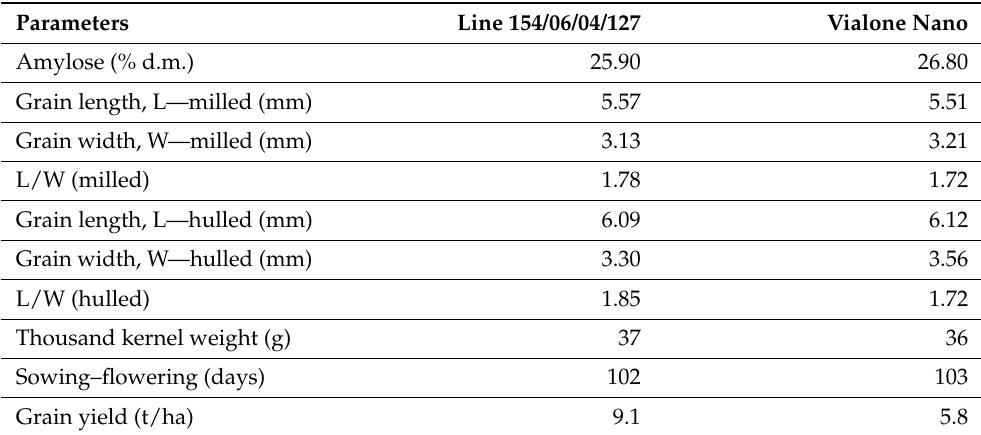
Table 5. Comparison of some agronomic, biometric, and qualitative traits for a selected introgression line (154/06/04/127) and the RP Vialone